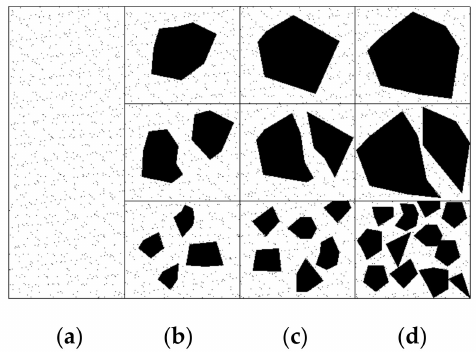
Figure 19. Schematic drawing of the block stone size and distribution. ( a ) A state in which the strength is completely controlled by the soil; ( b ) a state in which the strength is mainly controlled by the soil; ( c ) a state in which the strength is controlled by the soil and stone; ( d ) a state in which the strength controlled by the